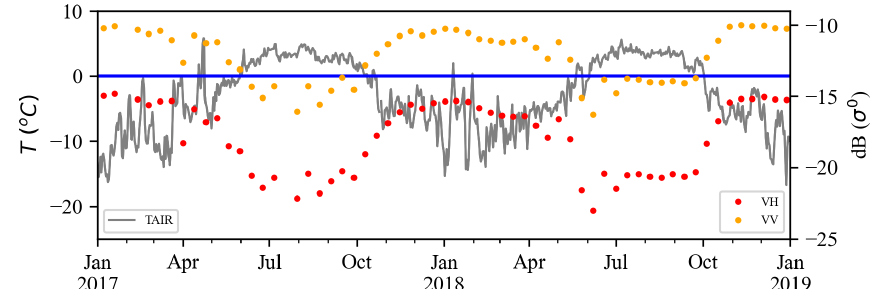
Figure 3. Time series chart of air temperature measured at the Yala Glacier base camp (4950ma.s.l.) and Sentinel-1 A/B descending backscatter averaged across the Yala Glacier for the years 2017–2018. Assessment of algorithm performance assuming mean daily air temperatures above 0 ◦ C indicates active melt results in 96% accuracy for melt classification across this time series in the VH polarized